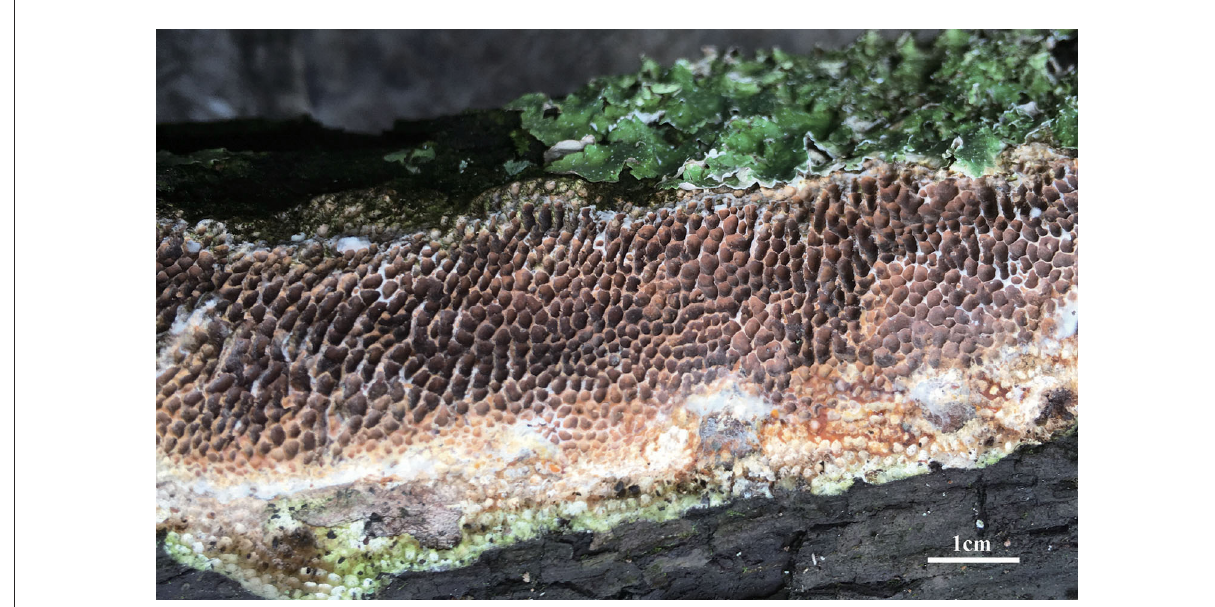
FIGURE13 A basidiocarp of Megasporia olivacea (holotype, Dai 17908).